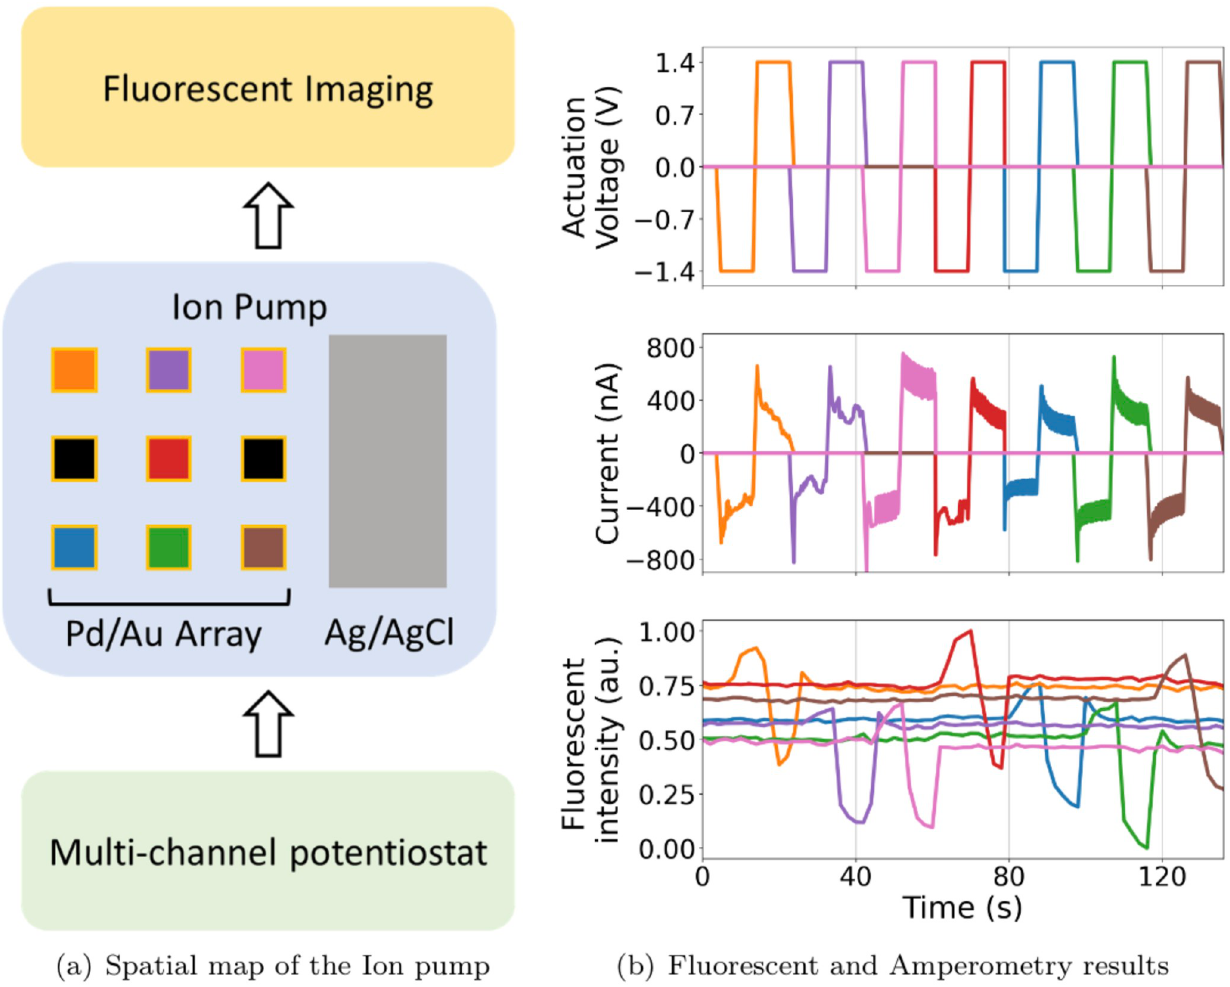
Fig 6. (A) Physical configuration of electrode placement of the ion pump. KEYENCE, BZ-X710 fluorescence microscope is used to image proton concentration (pH) every 2 seconds. Various colors represent different working electrodes and the black color indicates unused electrodes. (B) Actuation voltage and Amperometry results of in-house Ion pump and normalized fluorescent intensity correspond directly to Cl − ion concentration. The output shows that Cl − ion concentration changes according to the amperometry results from the ion